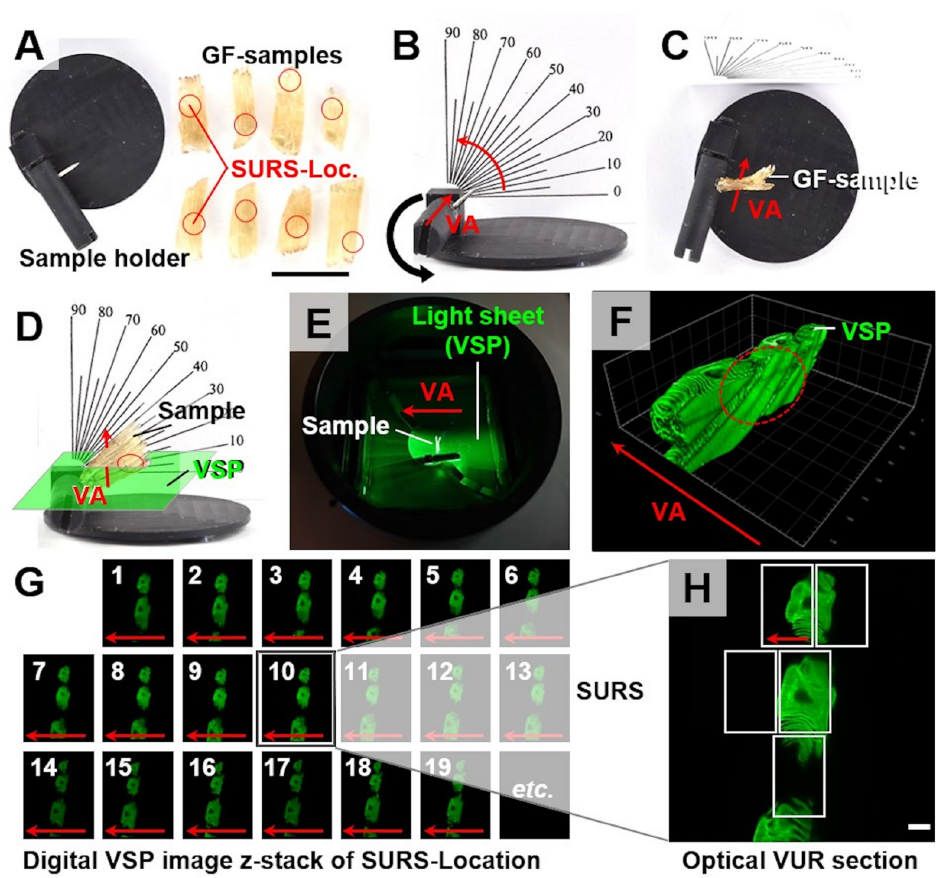
Fig 18. Generation of virtual optical VUR sections of cleared gill filament (GF) samples by LSFM. A. Left image side: top view of a sample holder with a rotatable axis equipped with a needle for sample attachment. Right image side: 8 stripe-shaped samples of optically cleared GF containing the SUR sampled locations ( SURS-Loc. , indicated by red circles). B-E. For generation of (virtual, optical) VUR sections, the GF sample is pinned to the rotatable axis ( B ) of the sample holder, so that the opercular side of the sample is oriented perpendicular to the (user-defined, virtual) vertical axis ( VA , indicated by a red arrow). The sample is then rotated in a defined rotation interval (compare to Fig 10 ). In D , a rotation angle of ~40˚ is shown. A green schematic plane indicates the orientation of a corresponding vertical section plane ( VSP ), relative to the VA and the sample. The sample holder with the attached sample is then transferred into the sample chamber of the LSF-microscope ( E ), maintaining the orientation of the sample to the (horizontal) plane of the laser light sheet. F, G. A z-stack series of digital autofluorescence images ( i . e ., virtual vertical section planes, parallel to VA) of the SURS-Loc. in the sample is acquired at an appropriate magnification ( G ). In F , the 3-D reconstruction of the region of the GF sample that contains the SURS-Loc. is shown. G, H. Depending on the applied magnification factor and the examined parameter, one to three images are (systematically) randomly sampled from the z-stack series of digital virtual optical VSP images of the SURS-Loc. ( e . g ., N˚10) of each GF sample for subsequent analysis of S V(SL/GF) (and V V(SL/GF) ). For estimation of S V(SL/GF) , inclusion of a calibrated size ruler and indication of VA in the VUR image are mandatory. Note that the orientation of the VA of the sample is always recognizable (in the cleared sample, the 3-D reconstruction, the (virtual) VUR section images, and in the SUR sampled fields of view within these VUR sections). Bar = 1 cm in A and = 200 μ m in H. 3-D reconstruction of the specimen, as illustrated in S11 Fig . From the acquired series of opti- cal (virtual) VUR section images from each sample, one to three image(s) per SUR sampled GF location are (systematically) randomly sampled for subsequent stereological analysis ( Fig 18G and 18H ). V and S are determined ( Figs 19 and 20 ), using the same point grids and V(SL/GF) V(SL/GF) point/cycloid probes, respectively, as illustrated for the analysis of histological (VUR) sections